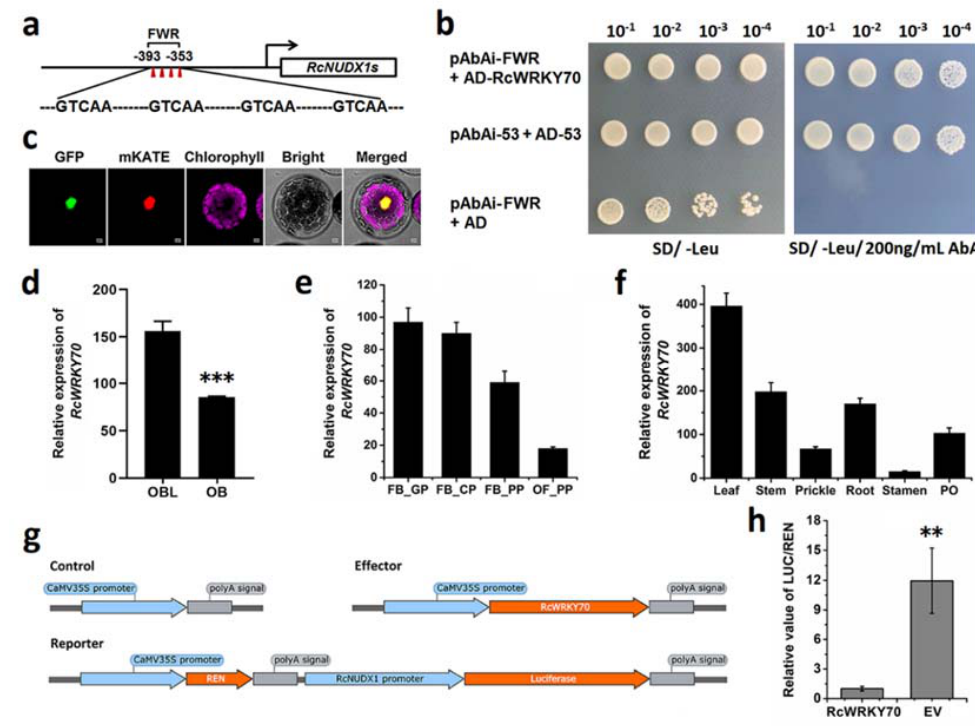
Figure 5. RcWRKY70 binds to and inhibits RcNUDX1 promoter activation. ( a ) Schematic diagram of the region of four W − box tandem repeats (FWR) in the RcNUDX1 promoter. ( b ) RcWRKY70 binds to the FWR regions, as shown by Y1H assays. pAbAi − 53 + AD − 53 represents the negative control; pAbAi − FWR + AD − RcWRKY70 represents the positive control. ( c ) Subcellular localization of RcWRKY70 in Arabidopsis protoplasts. mKATE served as nuclear marker. Scale bars, 10 μ m. ( d – f ) RT − qPCR analysis of RcWRKY70 expression. OB, stage 4 petals of Old Blush, OBL, stage 4 petals of Old Blush − like. FB_GP, green petals in the flower bud; FB_CP, petals changing colors in the flower bud; FB_PP, pink petals in the flower bud; OF_PP, pink petals on the open flower. PO, pistil and ovary of ‘Old Blush’. Data are means + SD of three biological replicates. *** p < 0.001 (Student’s t − test). ( g ) Schematic diagrams of vectors used in the dual − LUC assay. ( h ) In vivo interactions between RcWRKY70 and the RcNUDX1 promoter as tested by transient assays in N. benthamiana leaves. EV, empty vector (Control). Data are means ± SE of three biological replicates. ** p < 0.01 (Student’s t